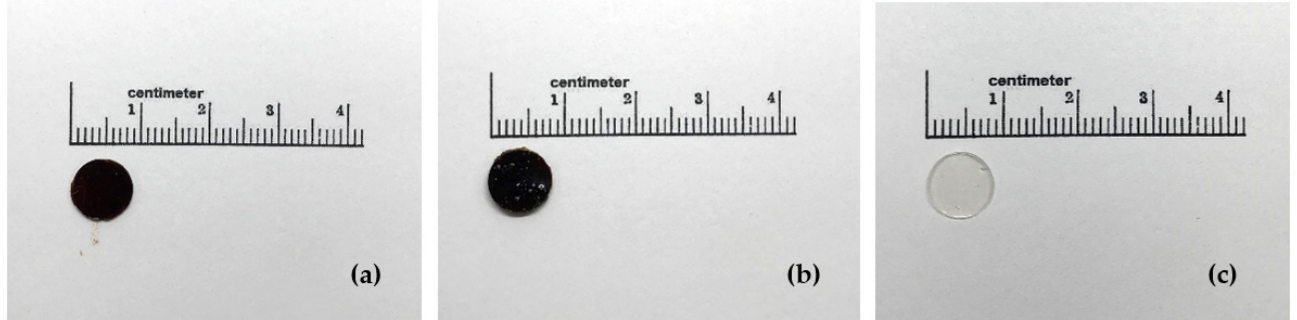
Figure 6. Gross appearance of MT-MAE-W/E ( a ), MT-Ma-W/E ( b ) and blank ( c ) films.